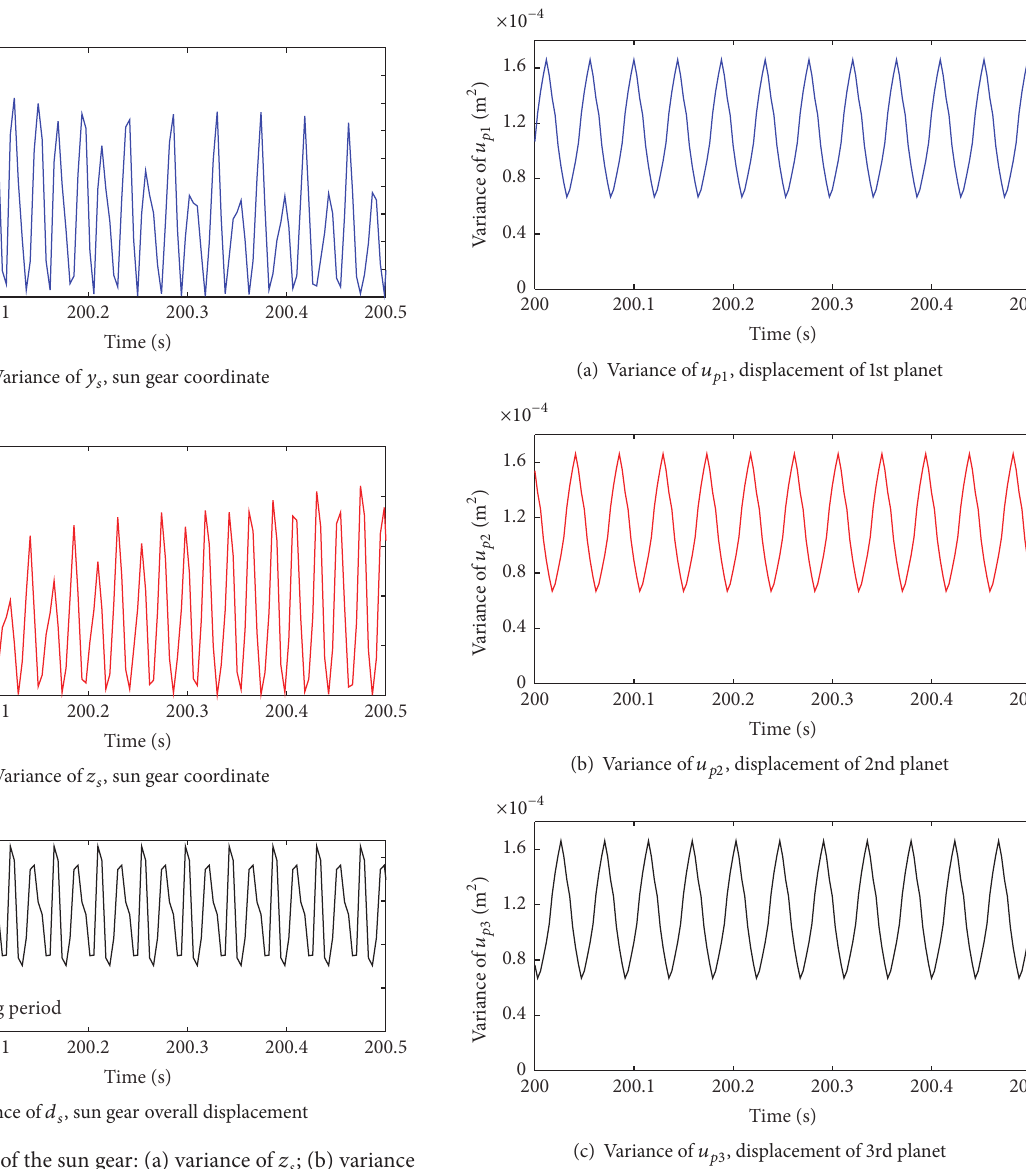
Figure 5: Variances of the planet gear rotation: (a) variance of 𝑢 𝑝1 ; (b) variance of 𝑢 𝑝2 ; (c) variance of 𝑢 𝑝3